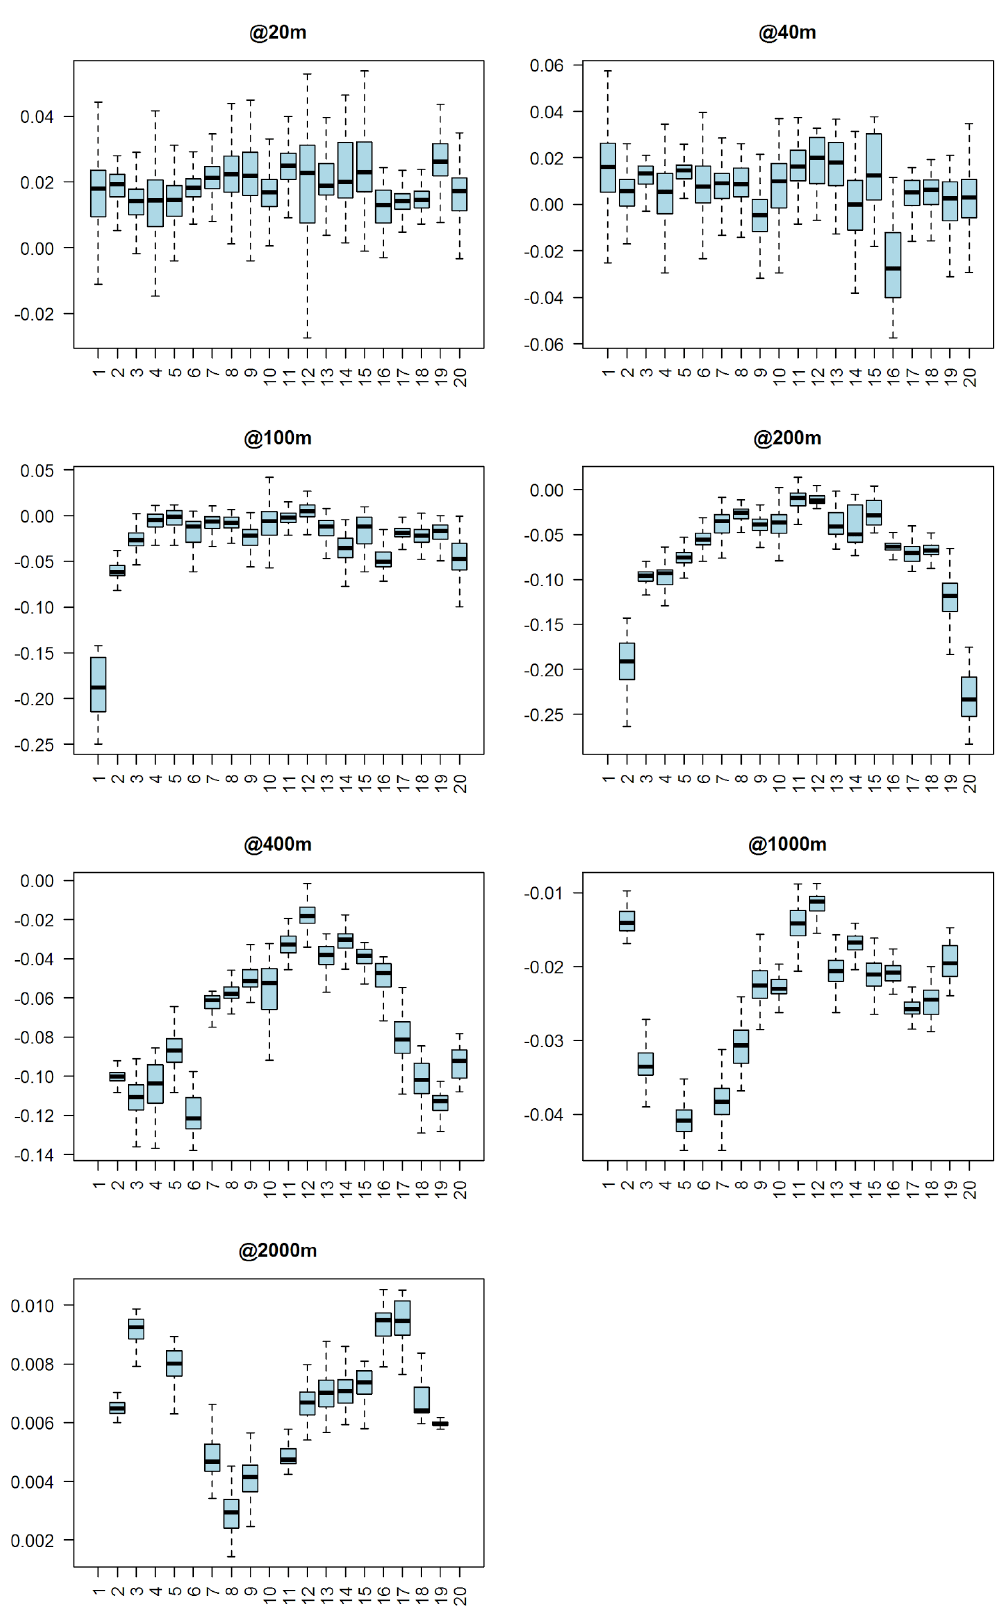
Figure 3. Box-and-whisker plots of July sound speed profile gradients (in units of (m/s)/m) at selected depths, by zone (x-axes show zone number).